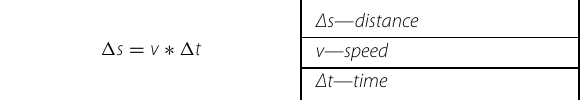
Table 5 Formula for calculating distance travelled at constant speed per unit of